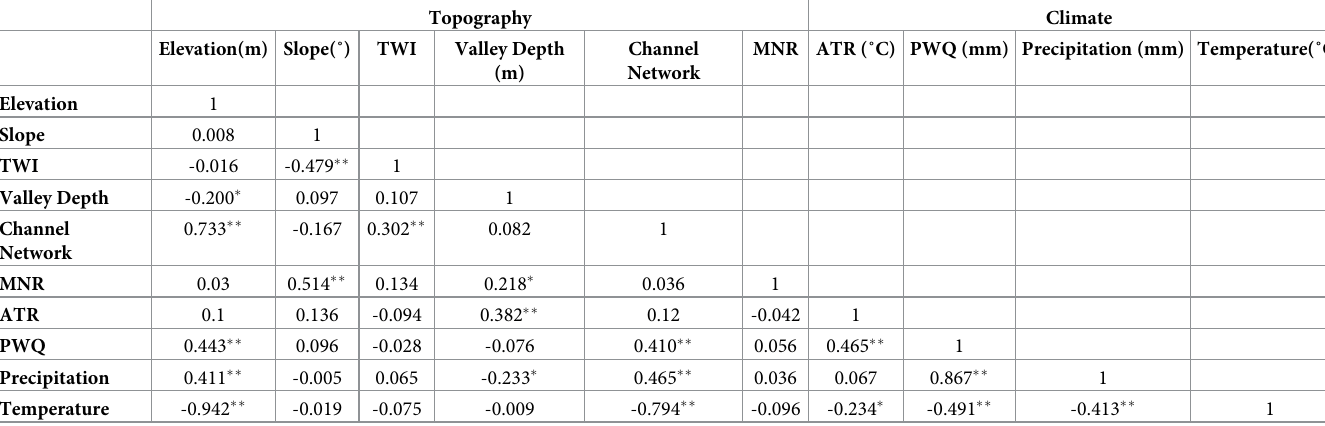
Table 4. Correlation between used factors.